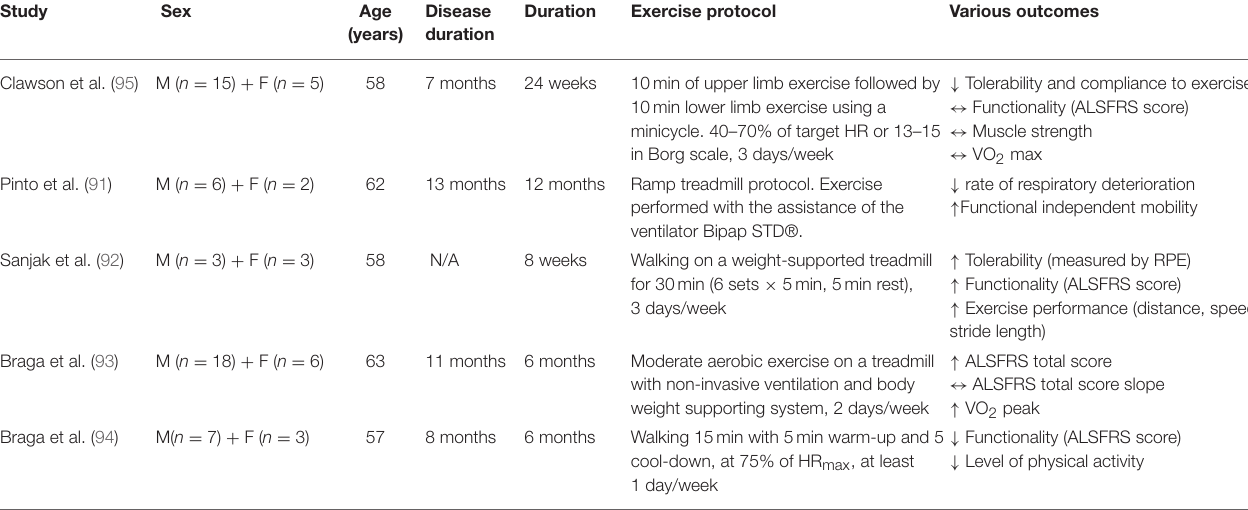
TABLE 3 | Summary of the effects of endurance training in ALS patients. Study Sex Age Clawson et al. (95) M ( n = 15) + F ( n = 5) 24 weeks 10min of upper limb exercise followed by